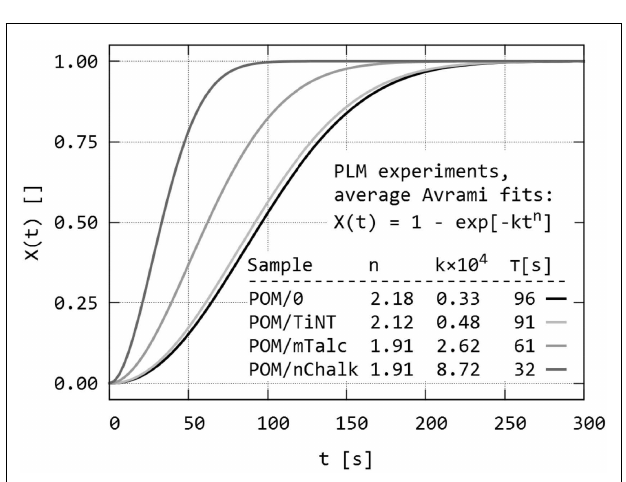
FIGURE 6 | Dynamic sandwich method – the second output from the experiments: the raw values of relative crystallinity, X ( t ), obtained from the intensity of polarized light in the sets of PLM micrographs as